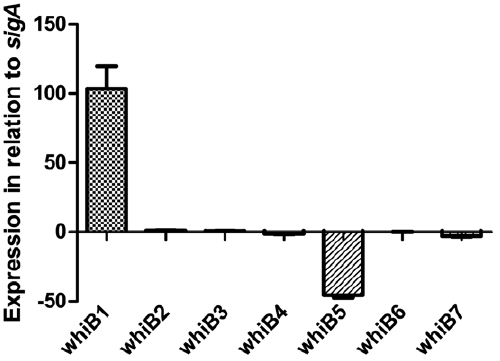
Figure 1. Relative abundance of whiB1-7 transcripts. mRNA levels of the seven M.tb whiB genes at mid-logarithmic growth in 7H9 presented as fold change in relation to sigA (set to 0). WhiB1 was highly expressed and whiB5 was under-expressed compared to the other whiB genes, which exhibited an expression level very close to that of sigA .